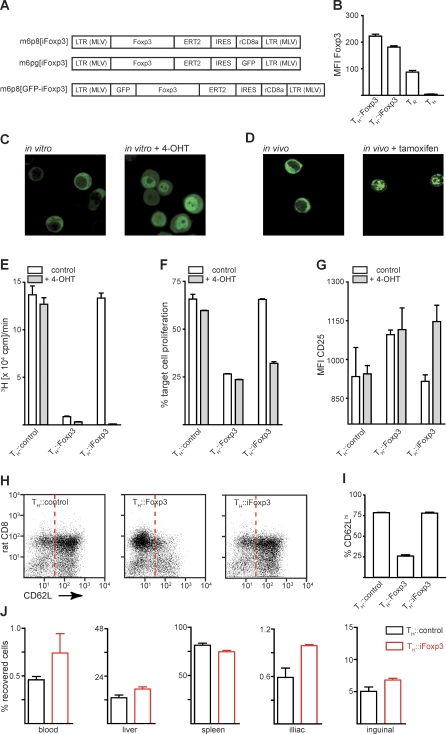
Inducible Foxp3(A) Diagram of iFoxp3 containing retroviral vectors m6pg[iFoxp3] either coexpressing GFP or a GPI-linked ratCD8 α-chain m6p8[iFoxp3], and m6p8[GFP-iFoxp3], which contains a fusion of GFP and iFoxp3.(B) MFI of intracellular stain for Foxp3 in TH::Foxp3 and TH::iFoxp3 cells compared to CD4+ TR and TH cells (n = 2 in each case).(C and D) Subcellular localization of GFP-iFoxp3 in TH::GFP-iFoxp3 cells (C) in vitro after 48 h in the presence or absence of 50 nM 4-OHT or (D) in vivo after three injections of tamoxifen or carrier.(E–G) Gain of TR cell function upon induction of iFoxp3.(E) Proliferation of TH::control, TH::Foxp3, and TH::iFoxp3 cells upon anti-CD3ɛ (0.6 μg/ml) stimulation measured by 3H-thymidine incorporation in the absence (white bars; n = 3 in each case) or presence of 50 nM 4-OHT (grey bars; n = 3 in each case).(F) A total of 1 × 105 CFSE-labeled CD4+CD25− target T cells were cocultured with 1 × 105 TH::control, TH::Foxp3 or TH::iFoxp3 cells and activated with anti-CD3ɛ (0.6μg/ml) (n = 2 in each case). The proliferation of target cells was measured based on CFSE dilution after 72 h, and the percentage of cells that had undergone at least one cell cycle is shown. The assay was performed in the absence (white bars) or the presence (grey bars) of 50 nM 4-OHT added to the transduced cells 24 h prior to setup.(G) MFI of CD25 48 h after transduction on TH::control, TH::Foxp3, and TH::iFoxp3 in the absence (white bars; n = 2 in each case) or presence of 50 nM 4-OHT (grey bars; n = 2 in each case).(H and I) Comparison of CD62L expression on TH::control, TH::Foxp3, and TH::iFoxp3 48 h after transduction with m6p8.(H) Representative FACS profiles of CD62L expression (n = 2 in each case).(I) Percentage of CD62Lhi cells within the transduced populations.(J) Comparison of the homing behavior of TH::control (black) and TH::iFoxp3 (red) cells. A total of 1 × 106 cells were transferred into each mouse (TH::control, n = 2; TH::iFoxp3, n = 3), and the tissues were analyzed 48 h later by flow cytometry. The diagrams represent the percentage of cells in each tissue calculated from the total number of cells recovered in all tissues together (5.4 × 105 ± 0.7 × 105 TH::control cells and 3.1 × 105 ± 0.4 × 105 TH::iFoxp3 cells; values ± SEM).